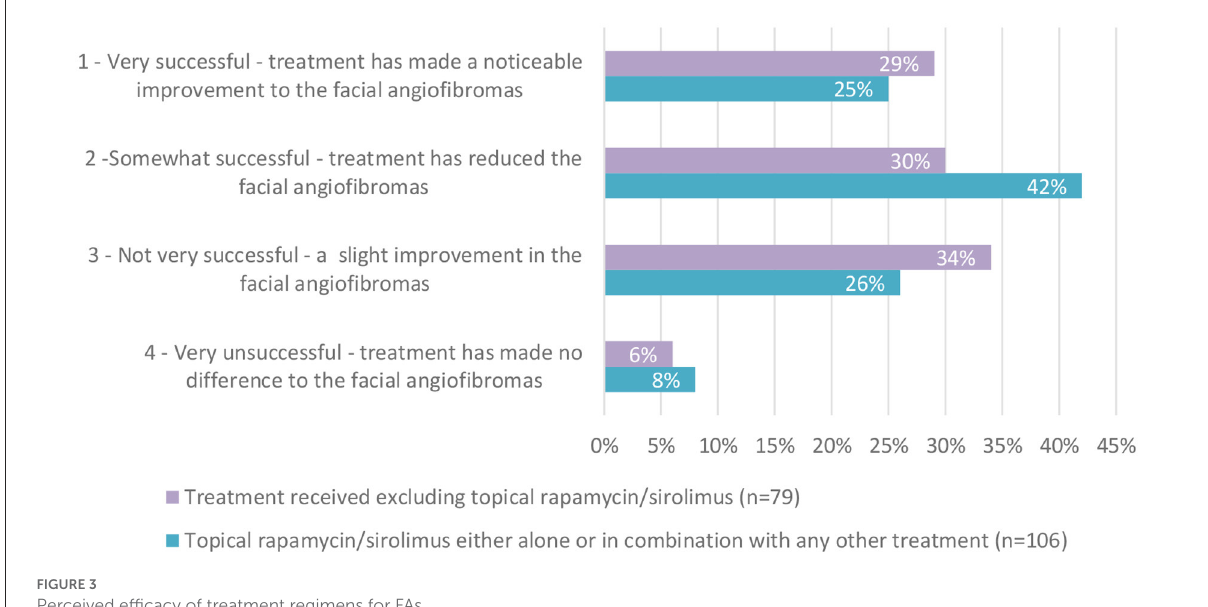
FIGURE3 Perceived efficacy of treatment regimens for